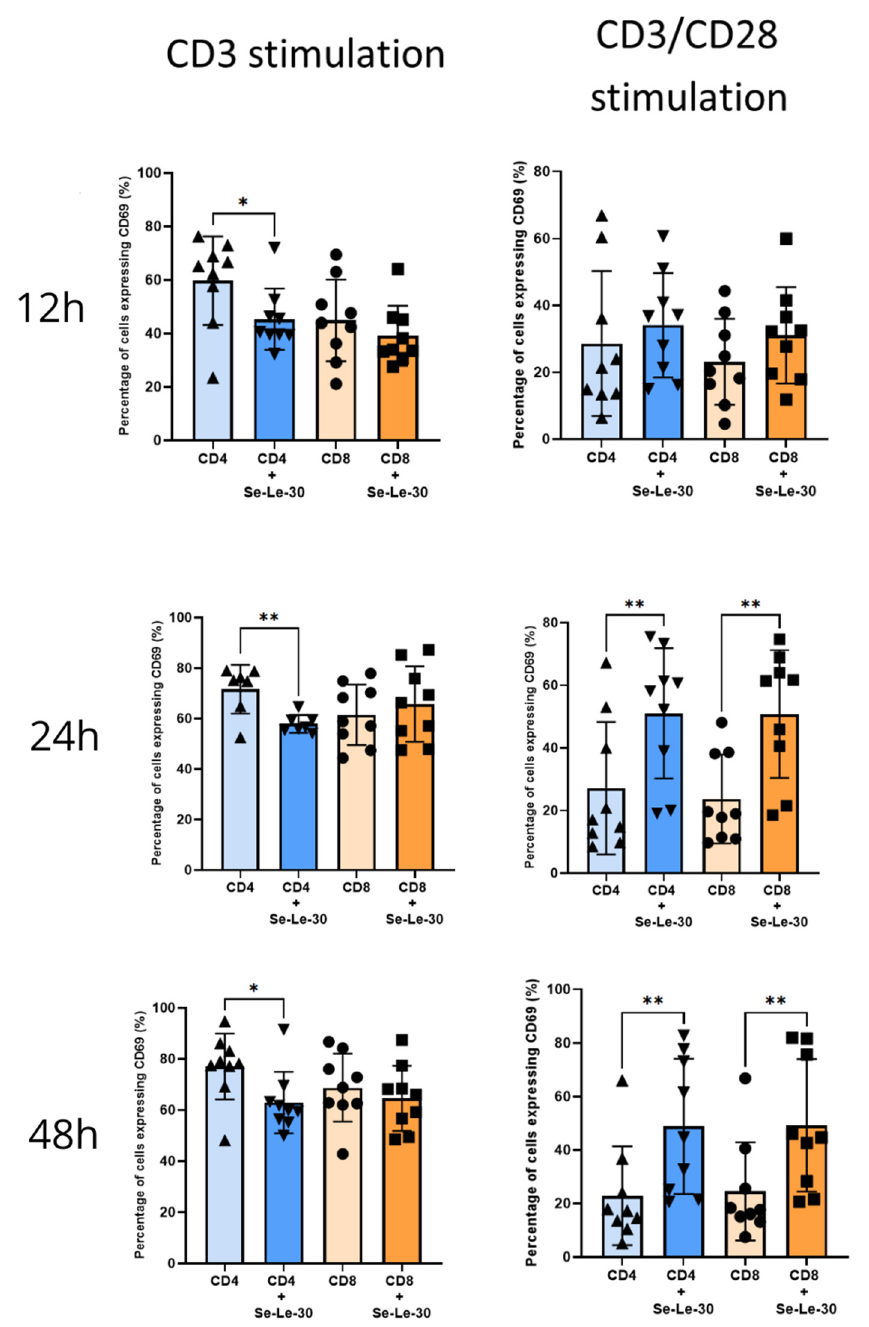
Figure 2. Effects of Se-Le-30 on human CD4 + and CD8 + T cells activation. PBMCs from nine healthy donors were stimulated with anti-CD3 Ab or anti-CD3/CD28 Abs and treated with Se-Le-30 (100 µ g/mL) for 12, 24, or 48 h. The expression of the CD69 marker on the surface of CD4 + and CD8 + T cells was detected by flow cytometry. * p < 0.05; ** p < 0.01. Points on bar charts represent experiments conducted with individual donors.